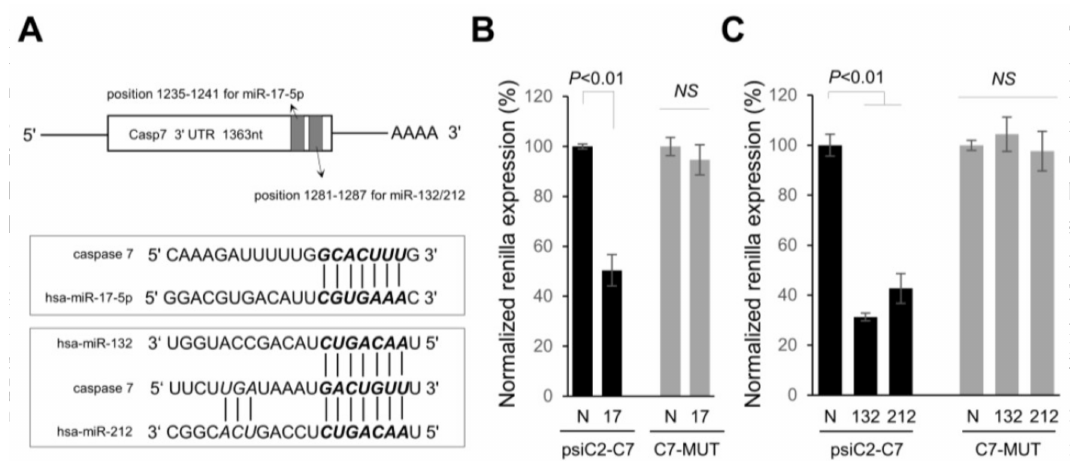
Figure 2. Caspase-7 (casp-7) is directly targeted by miR-17-5p and miR-132-3p/-212-3p in pancreatic tumor cells. ( A ) Schematic representation showing the location of putative miR-17-5p and -132-3p/-212-3p binding sites harbored in the 3 (cid:48) UTR of casp-7 mRNA. ( B ) Luciferase reporter plasmids carrying a wild-type (psiC2-C7) or mutant binding sequences in 3 (cid:48) UTR of casp-7 (C7-MUT) were co-transfected in PANC-1 cells with the negative control of pre-miR precursor (N) or miR-17-5p precursor (17) at 50 nM concentration. At 24 h after transfection, luciferase activity was measured using dual-luciferase assays. Normalized Renilla luciferase activity in cells transfected with N was set at 100%. The data are the mean ± s.d. of at least 3 independent experiments. ( C ) Wild type (psiC2-C7) or mutant plasmids were co-transfected in PANC-1 cells with the negative control of pre-miR precursor (N), miR-132-3p precursor (132) or miR-212-3p precursor (212) at 50 nM concentration. At 24 h after transfection, luciferase activity was measured using dual-luciferase assays. Normalized Renilla luciferase activity in cells transfected with control oligo (N) was set at 100%. The data are the mean ± s.d. of at least 3 independent experiments. NS, not